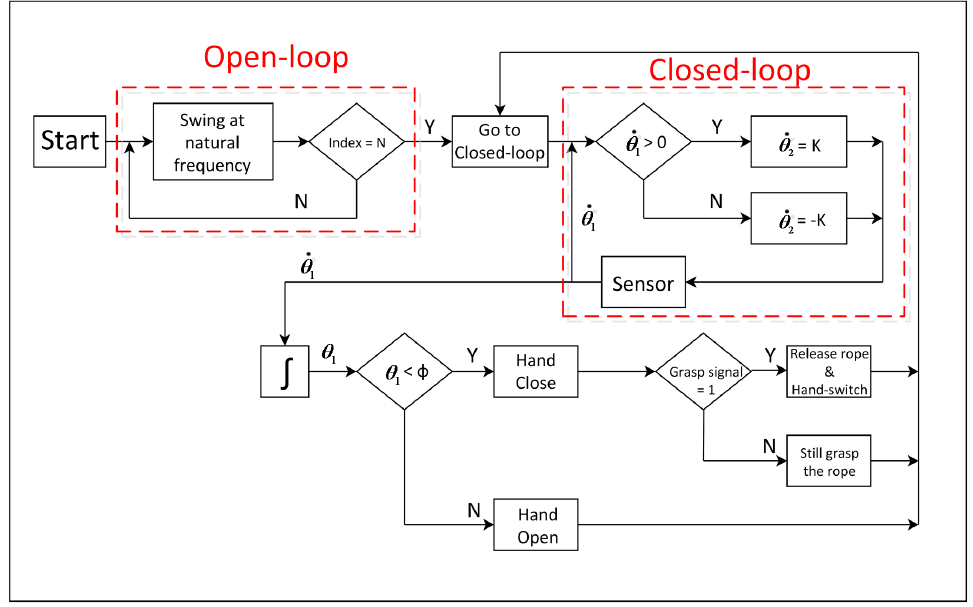
Figure 7. The overall control flowchart.